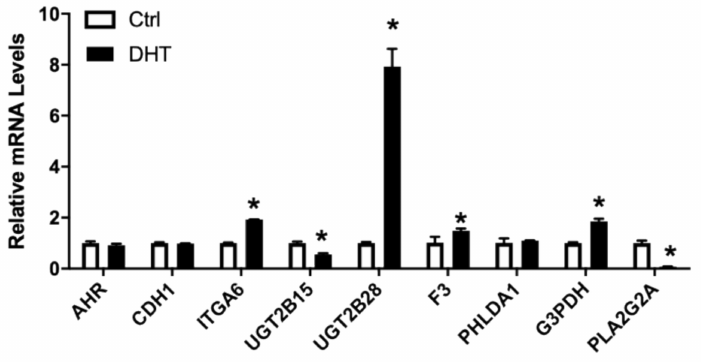
Figure 4. Relative mRNA levels of selected genes in LNCaP cells treated without/with 1 nM DHT. LNCaP cells were treated with 1nM DHT, RNA isolated, and the gene expression analyzed, as described in Materials and Methods. Results were normalized to the untreated control and expressed as relative mRNA levels (mean ± SD, n = 3); p -values ≤ 0.05 were considered as significant and * indicates significantly different from